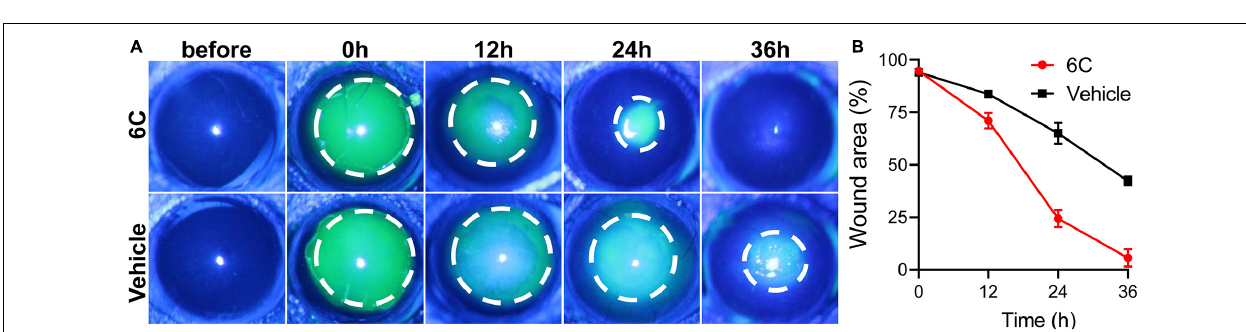
corneal epithelium in the 6C treatment group was 25% of that in the control group ( Figure 8B ). By the 36th hour, the wound in the 6C treatment group had healed completely, while the corneal epithelium in the solvent group still had